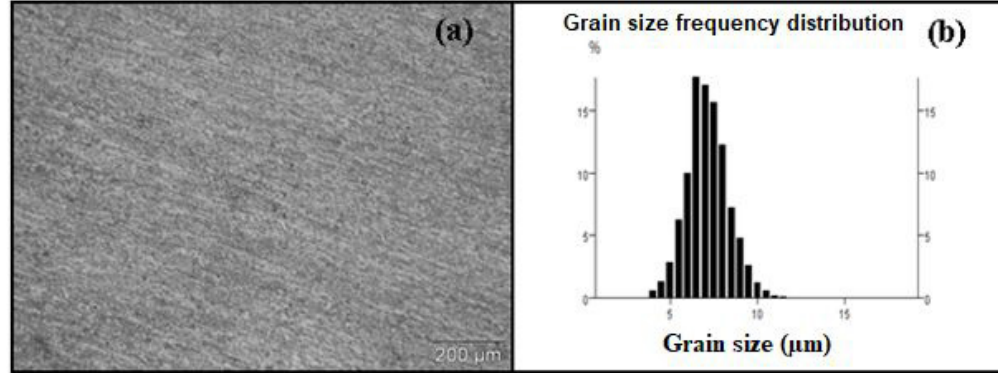
Figure 2. Grain size distribution of X80 steel. In (a) micrograph of the coupon with 100x magnification and (b) grain size graph versus percentage referring to the grain size.